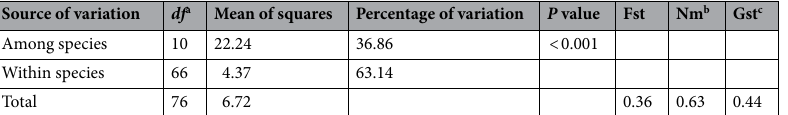
Table 6. Analysis of molecular variance (AMOVA) among and within Thymus species using SRAP markers. a Degrees of freedom. b Gene flow. Nm = estimate of gene flow from Gst or Gcs. E.g., Nm = 0.5(1—Gst)/Gst; McDermott and McDonald 58 . c Diversity among